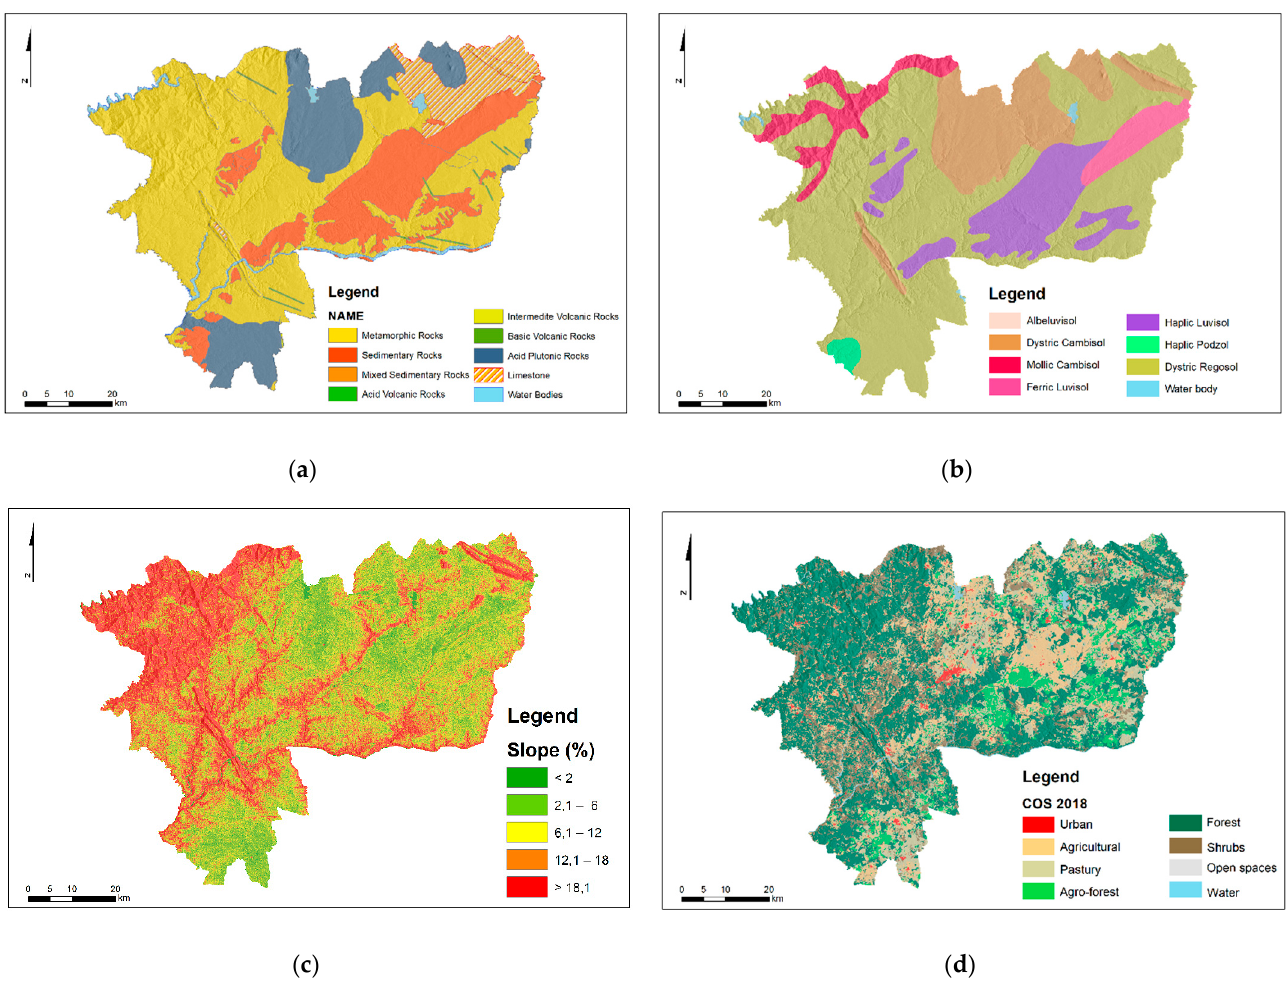
Figure 2. Base map variables of the study area: ( a ) lithology, ( b ) soil, ( c ) slope, and ( d ) anthropogenic influence.